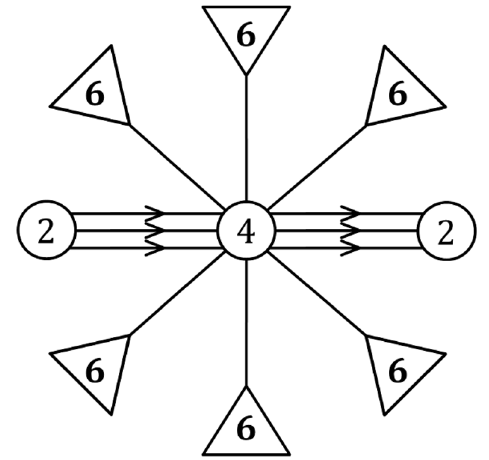
Figure 3 . Triality frame